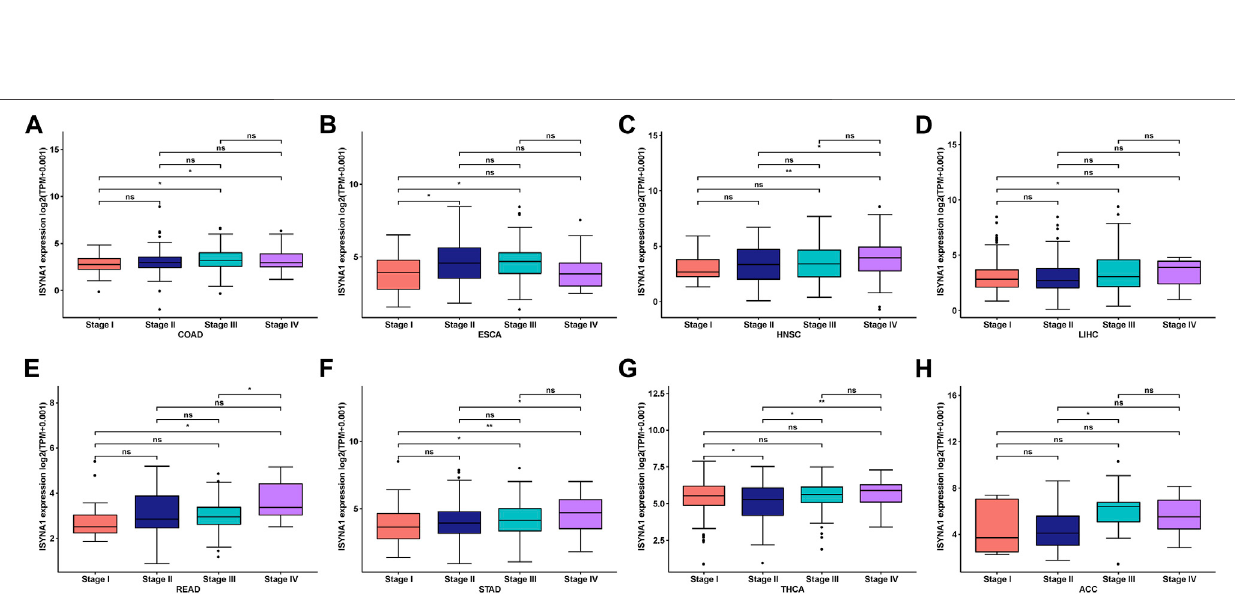
Frontiers in Cell and Developmental Biology |